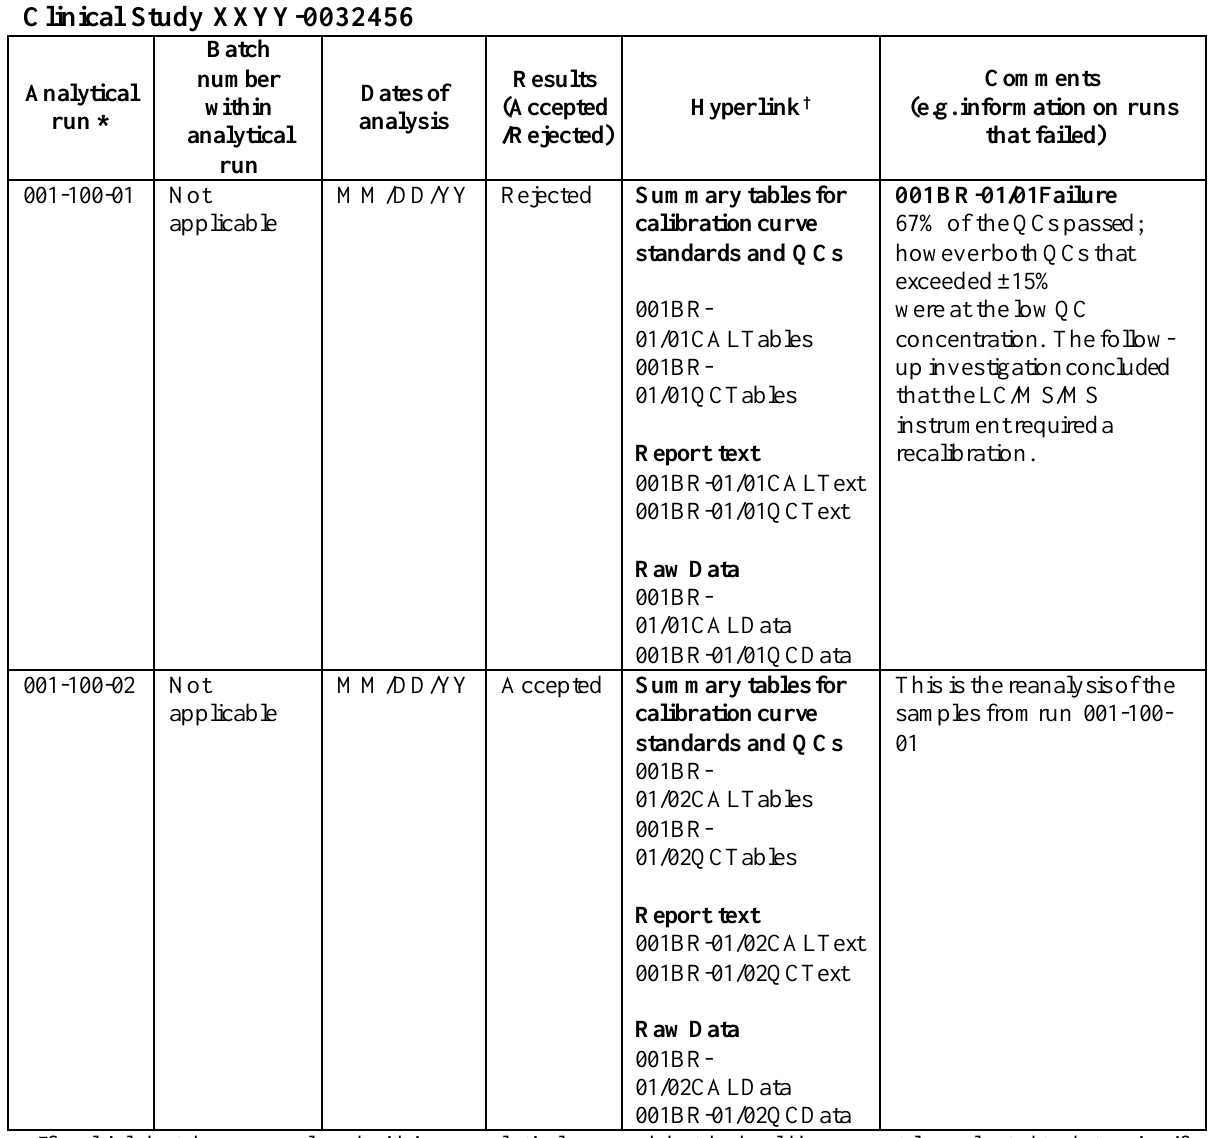
Table 4. Example of Summary Analytical Runs for a Bioanalytical Study Report* (this table contains fictitious information, which serves illustrative purposes only) Sponsors and applicants should provide a table summarizing both the failed and accepted runs for each